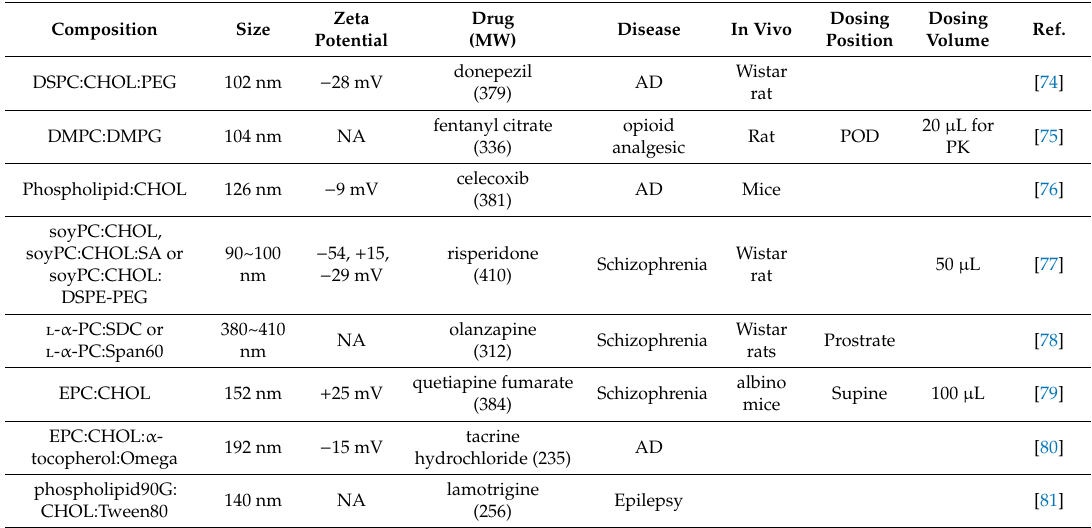
Table 2. Liposomal formulations designed for nose-to-brain delivery of lipophilic / amphiphilic